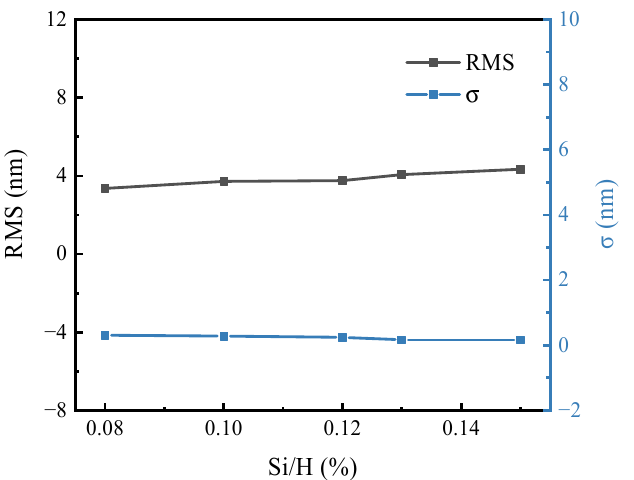
Figure 10. Locations of surface roughness measurements for 6-inch wafers.